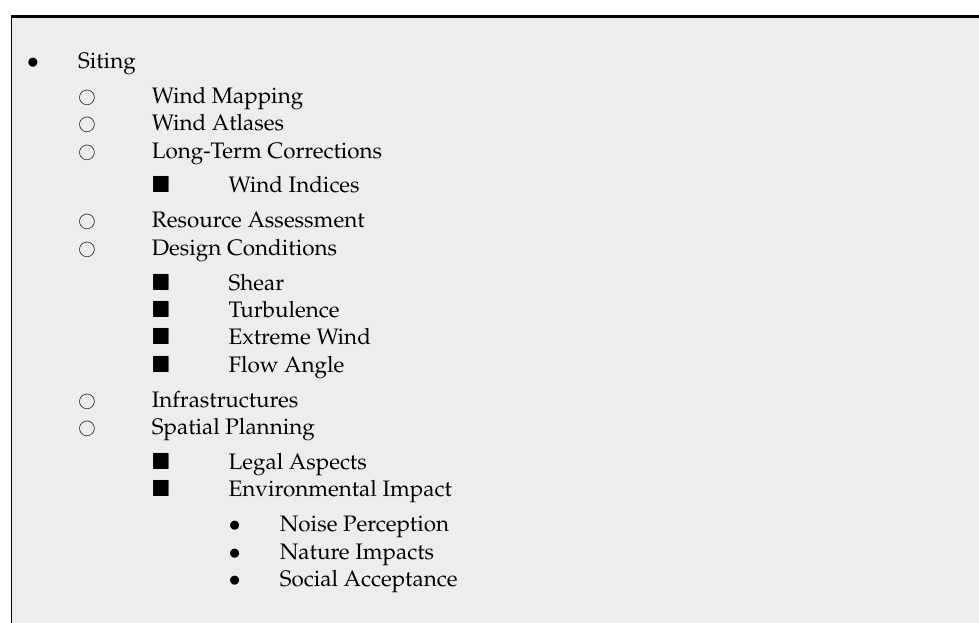
Table 12. Hierarchy for Siting-related topics in the Production of Electricity from Wind Power.